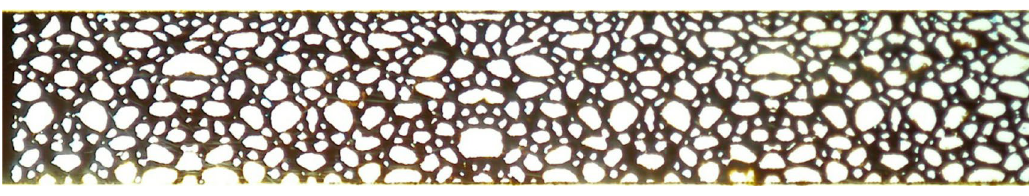
Fig. 13 Oil–saturated sandstone flow pattern (grains in white